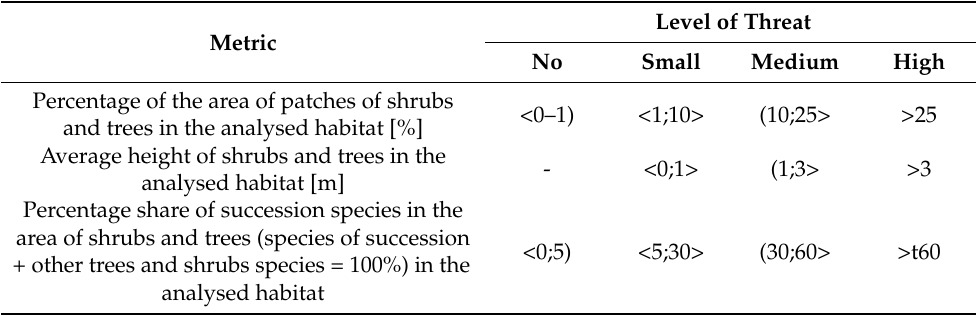
Table 4. The criteria used to define the levels of internal threat of succession for selected individual habitats. Level of Threat Metric No Small Medium High Percentage of the area of patches of shrubs and trees in the analysed habitat [%] analysed habitat [m]